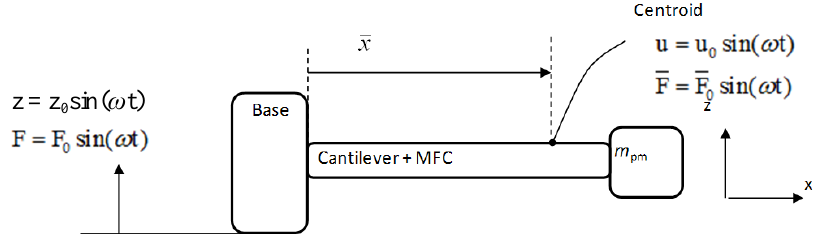
Figure 11. Harmonic excitation of the vibration-based energy harvester.